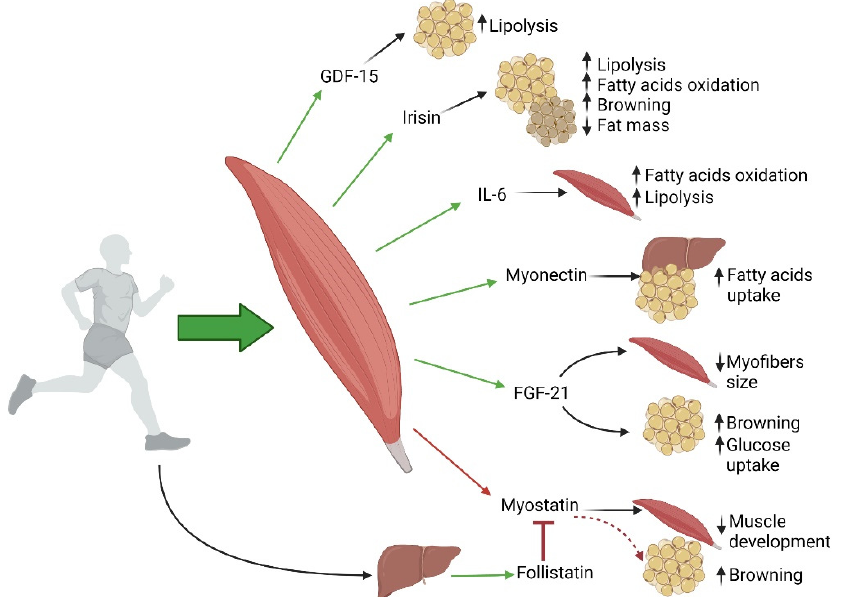
Figure 1. Skeletal muscle as an endocrine organ: paracrine and autocrine effects of muscle contraction-induced myokines. Exercise stimulates the release of myokines with autocrine, paracrine, or endocrine functions (green arrows, induction). In particular, several myokines play a role in the maintenance of whole-body metabolic homeostasis. GDF-15, IL-6, and irisin stimulate intramyocel- lular triacylglycerol lipolysis. Irisin and FGF-21 induce browning in adipose tissue. Irisin and IL-6 also stimulate fatty acid oxidation. Myonectin affects adipose tissue and liver functions, increasing fatty acids uptake. Myostatin is a negative regulator of skeletal muscle mass and inhibits muscle hypertrophy: exercise induces a downregulation of myostatin (red arrow), thus promoting muscle development. In addition, follistatin, expressed by the liver in response to physical activity (green arrow, induction), is able to antagonize myostatin (red line, inhibition), promoting browning of WAT (dotted red arrow). Black arrows indicate positive (up) or negative (down) modulation of downstream targets. Abbreviations: FGF21, fibroblast growth factor 21; IL-6, interleukin-6; GDF-15, growth differentiation factor 15.